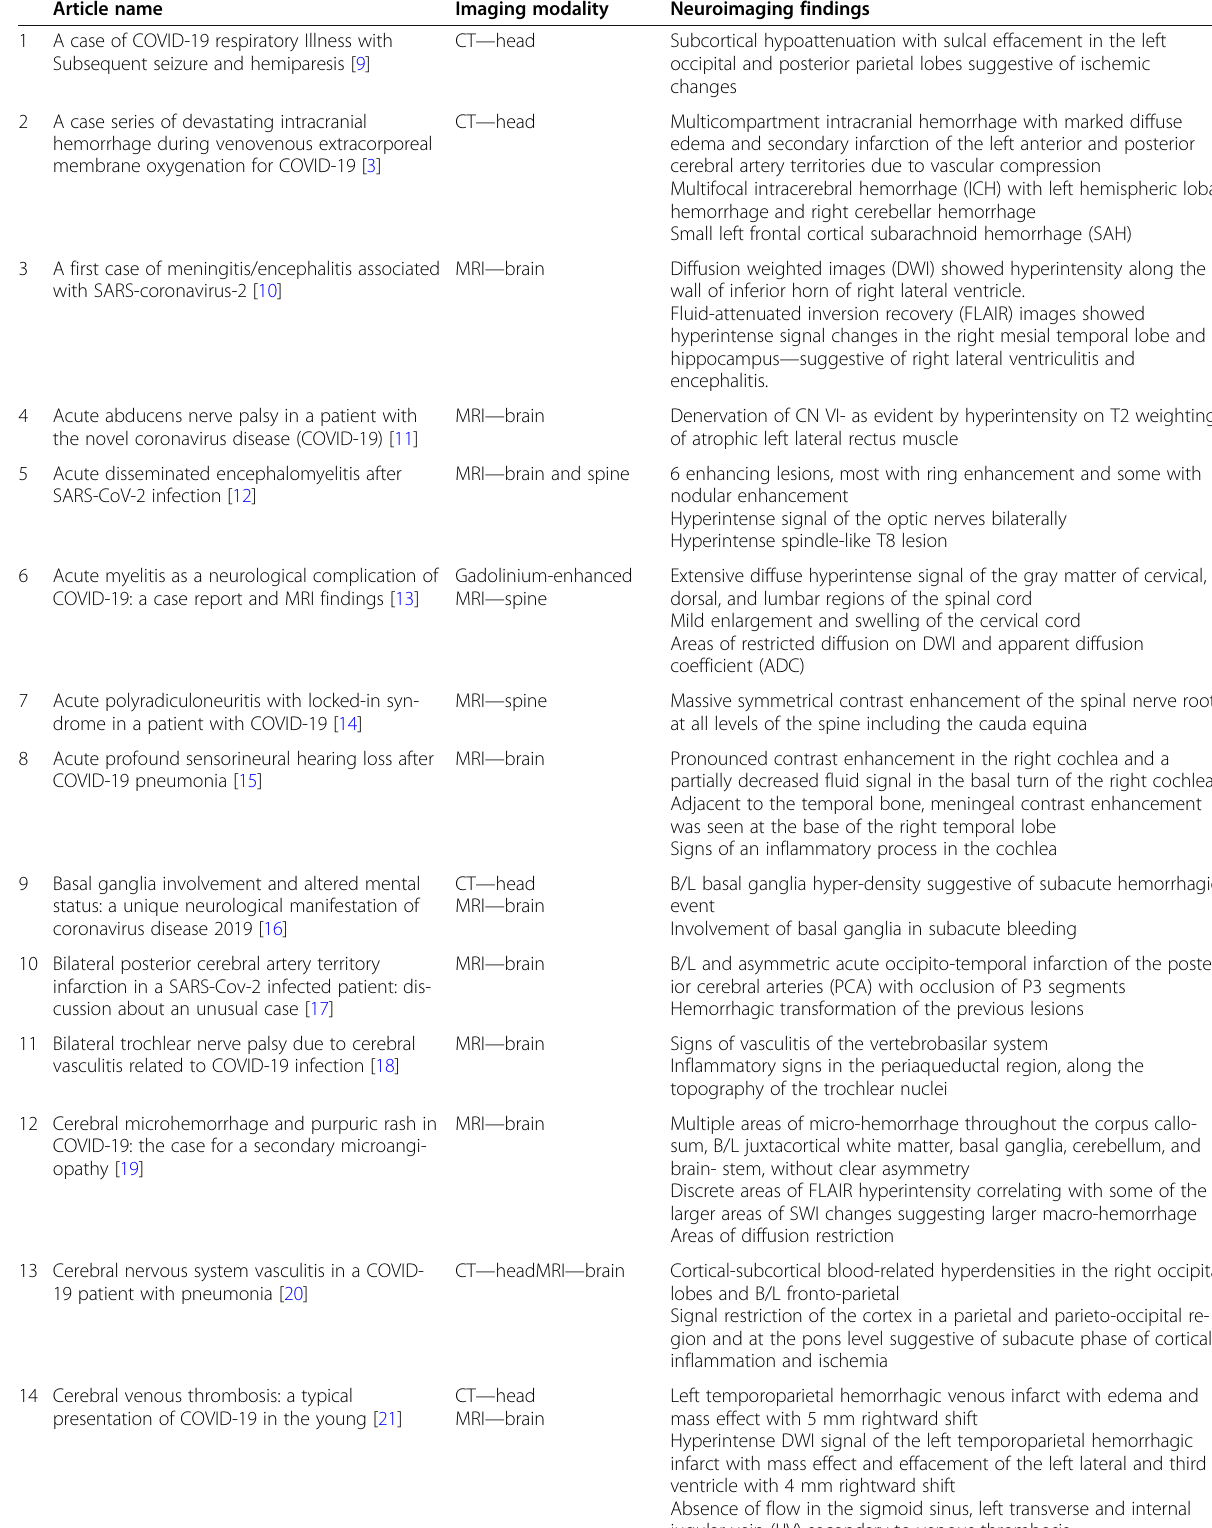
Table 1 Reported studies on COVID-19 patients with neurological manifestations with positive findings on major